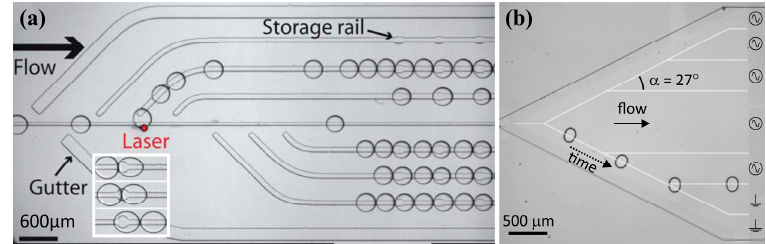
Figure 3. ( a ) Guiding of droplets by surface energy rails. The laser spot is used to select and force droplets onto the rail. A local widening of the rail serves as a deeper surface energy well where trapping will occur. A droplet can be pushed out of the well by a consecutive droplet. Adapted from [5] with permission of The Royal Society of Chemistry. ( b ) Guiding of droplets by electrostatic potential rails. Depending on which electrodes are activated a droplet will be guided towards one of six lateral positions in the channel. Adapted from [26] with permission of The Royal Society of Chemistry.